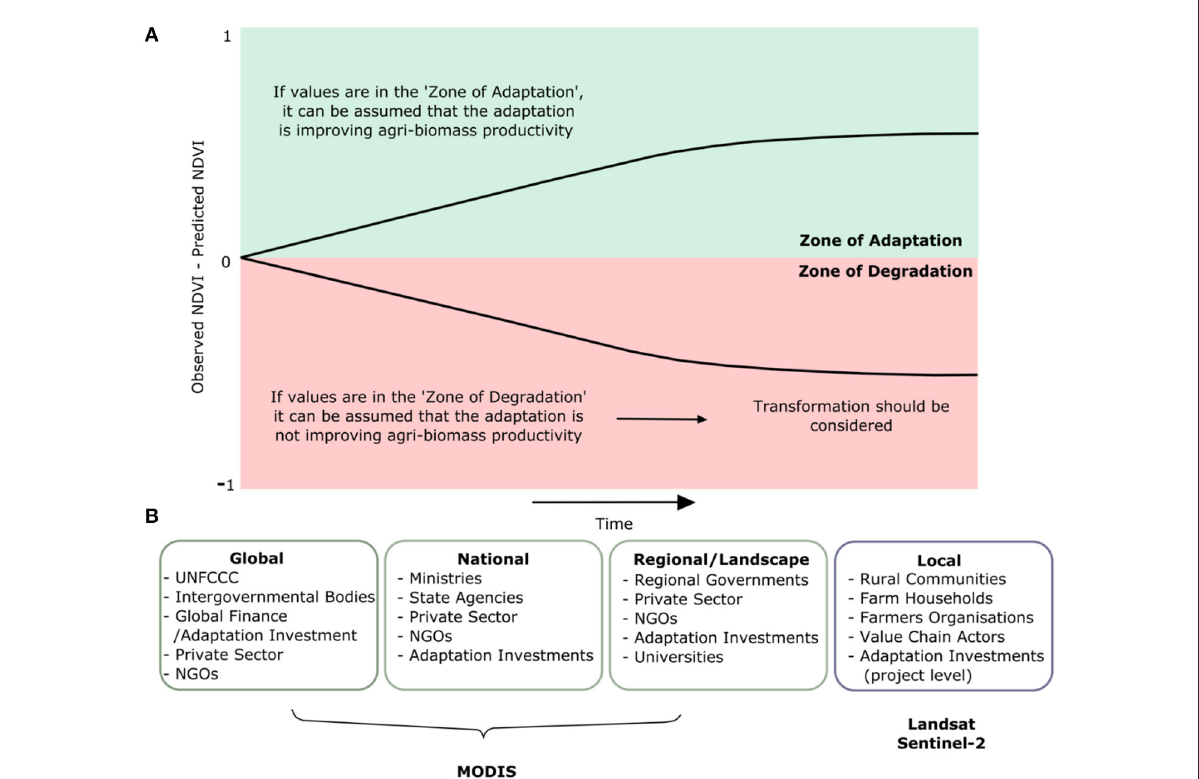
FIGURE2 (A) Schematic showing theoretical time-series trajectories of the Biomass CAI. Positive Biomass CAI values in the “Zone of Adaptation” reflect larger observed NDVI values than predicted NDVI values, meaning the adaptation has improved agri-biomass (crop) productivity. Observed NDVI values less than predicted NDVI values will give a negative Biomass CAI “score” in the “Zone of Degradation”, meaning the adaptation intervention has not improved agri-biomass productivity and a transformational shift could be considered; (B) End-users at Global/national scale (Conde and Lonsdale, 2005; FAO, 2013; Ford et al., 2013, 2015; Ford and Berrang-Ford, 2016; Berrang-Ford et al., 2019), regional/landscape scale (Conde and Lonsdale, 2005; Galarraga et al., 2011; FAO, 2013) and local cale (Conde and Lonsdale, 2005; FAO, 2013; Sherman and Ford, 2014) of the TAPAS Biomass CAI at corresponding spatial resolutions with appropriate satellites outlined. Sentinel-2 (Drusch et al., 2012) and Landsat (Wulder et al., 2019) appropriate satellites for local level analysis, while MODIS (Dinan et al., 2015) is an appropriate satellite for analysis at landscape, national and global